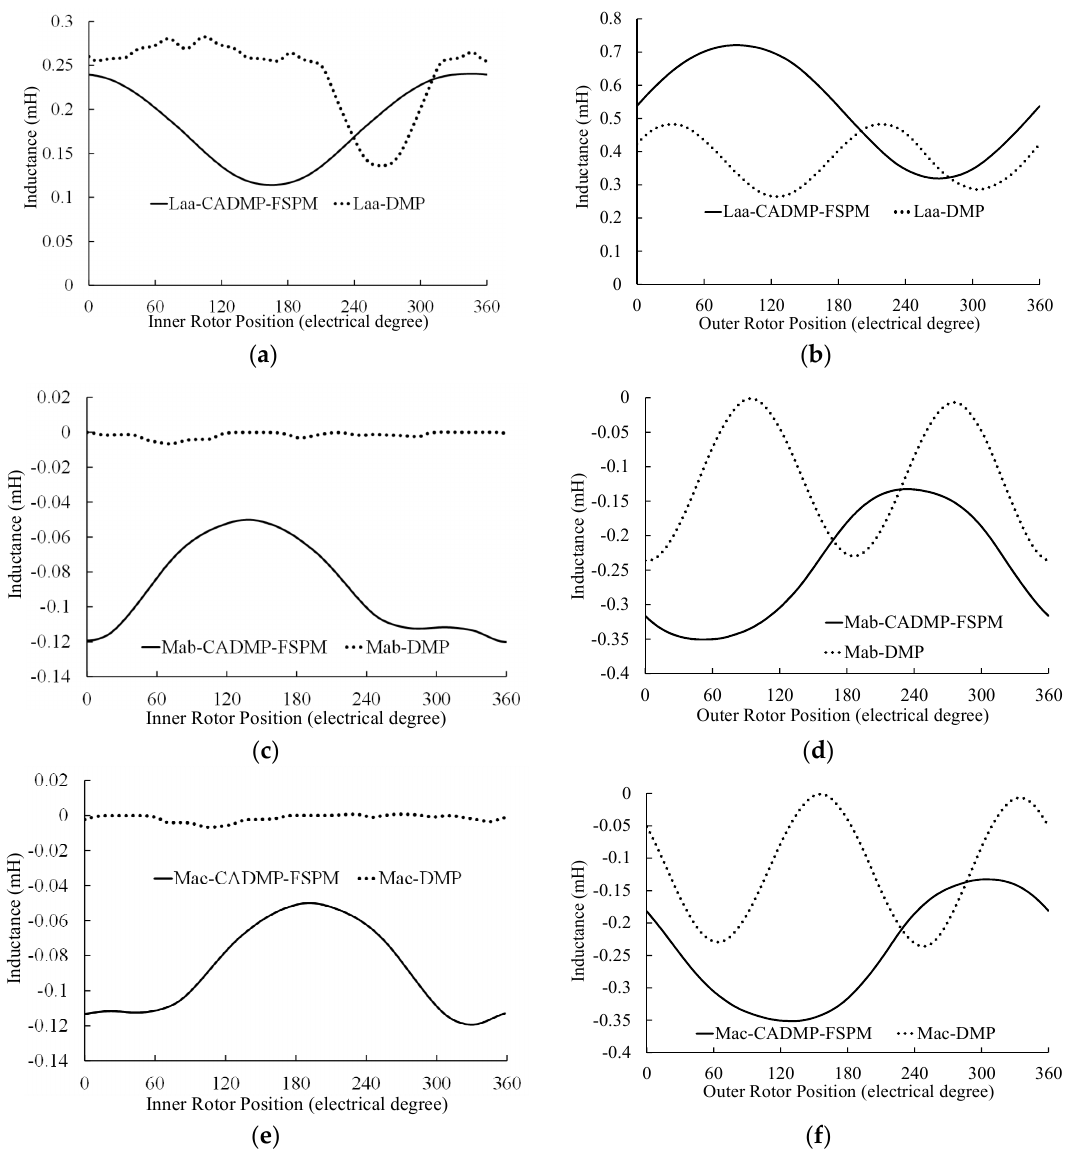
Figure 9. Winding self ‐ inductance and mutual inductance of two machines. ( a ) L aa of inner machines; ( b ) L aa of outer machines; ( c ) M ab of inner machines; ( d ) M ab of outer machines; ( e ) M ac of inner machines; ( f ) M ac of outer machines.